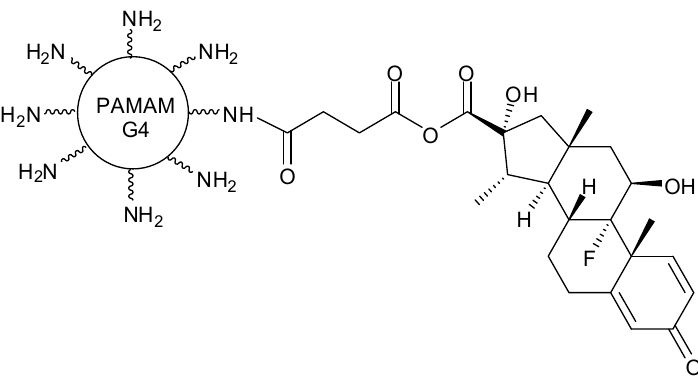
Figure 2. G4 PAMAM dendrimer conjugate with dexamethasone [29].